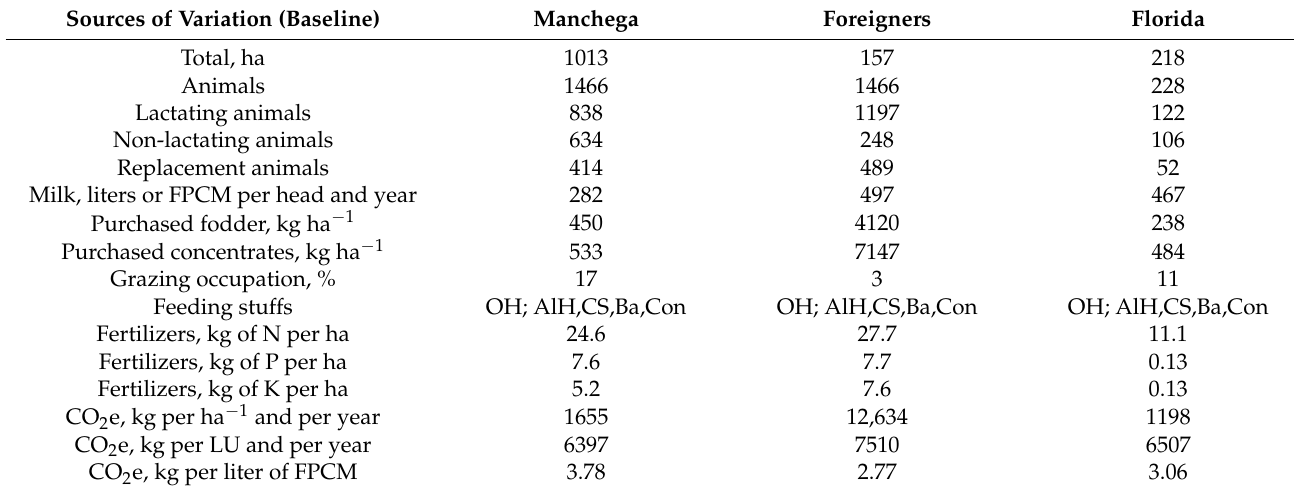
Table 1. Characteristics of the herds used in the